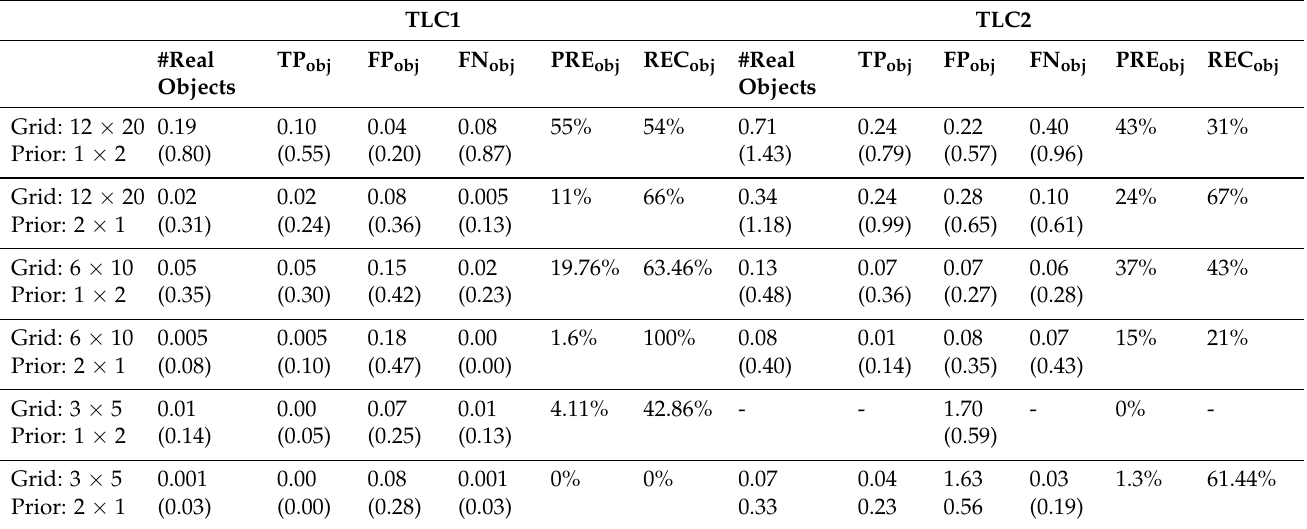
Table 2. Mean and standard deviation (between parentheses) of TP obj , FP obj , FN obj and percentage of PRE obj and REC obj for each camera, grid, and prior of the SSD ret model. TLC1 TLC2